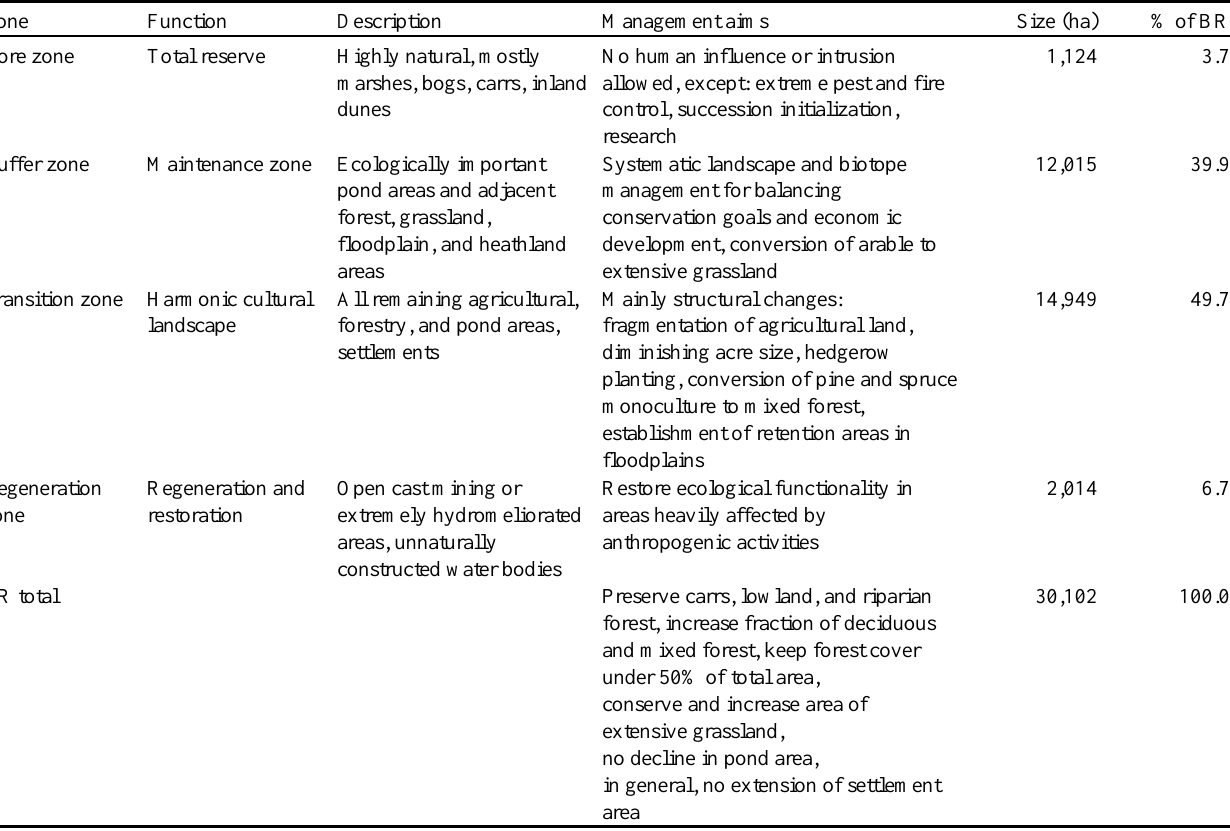
Table 1 . Zones, functions, and management aims in the biosphere reserve (BR) (Biosphärenreservat Oberlausitzer Heide- und Teichlandschaft 1996, Syrbe et al. 1998, Bastian et al.